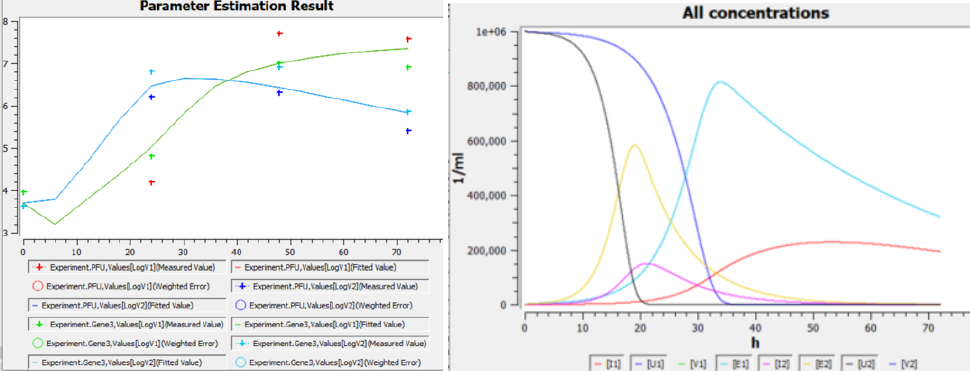
Figure 4. Left : Replication of the SARS-CoV-2 variants Delta (green + red) and Omicron (blue + cyan) in hNECs in the experiment [2] (markers, data are taken from Figure 2C as described in Section 2.4) and in the homogeneous version of the model (1) (lines). Right : concentrations of cells in the same solutions. Figures are screenshots from COPASI. Model parameters are listed in Table